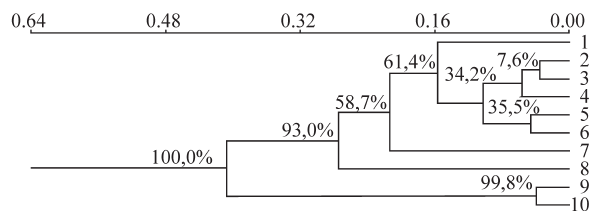
Figure 2 - Genetic divergence pattern among ten “cagaita tree” popula- tions, defined by the UPGMA clustering, based on the genetic identity ob- tained from Nei’s genetic distances (1972). Cophenetic correlations equal to 0.943.